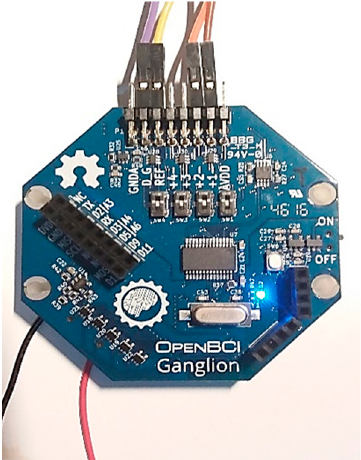
Figure 3. Overview of the Open Brain–Computer Interface (BCI) Ganglion unit used.